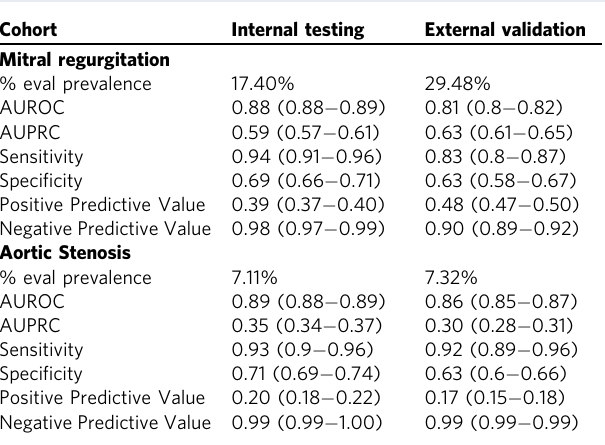
Table 3 Classi fi cation performance.